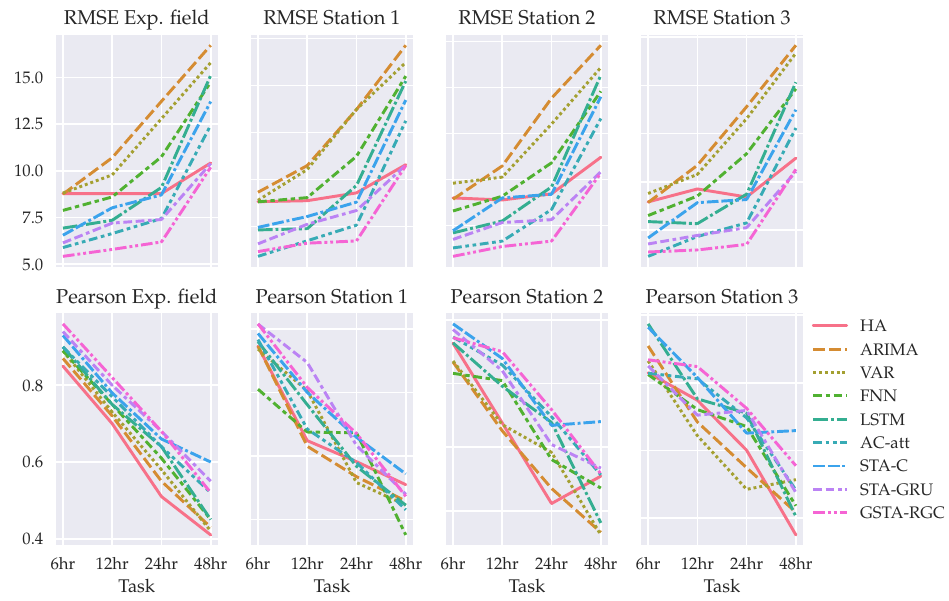
Figure 7. RMSE and Pearson statistic results regarding forecasting on the experimental field and three nearest weather